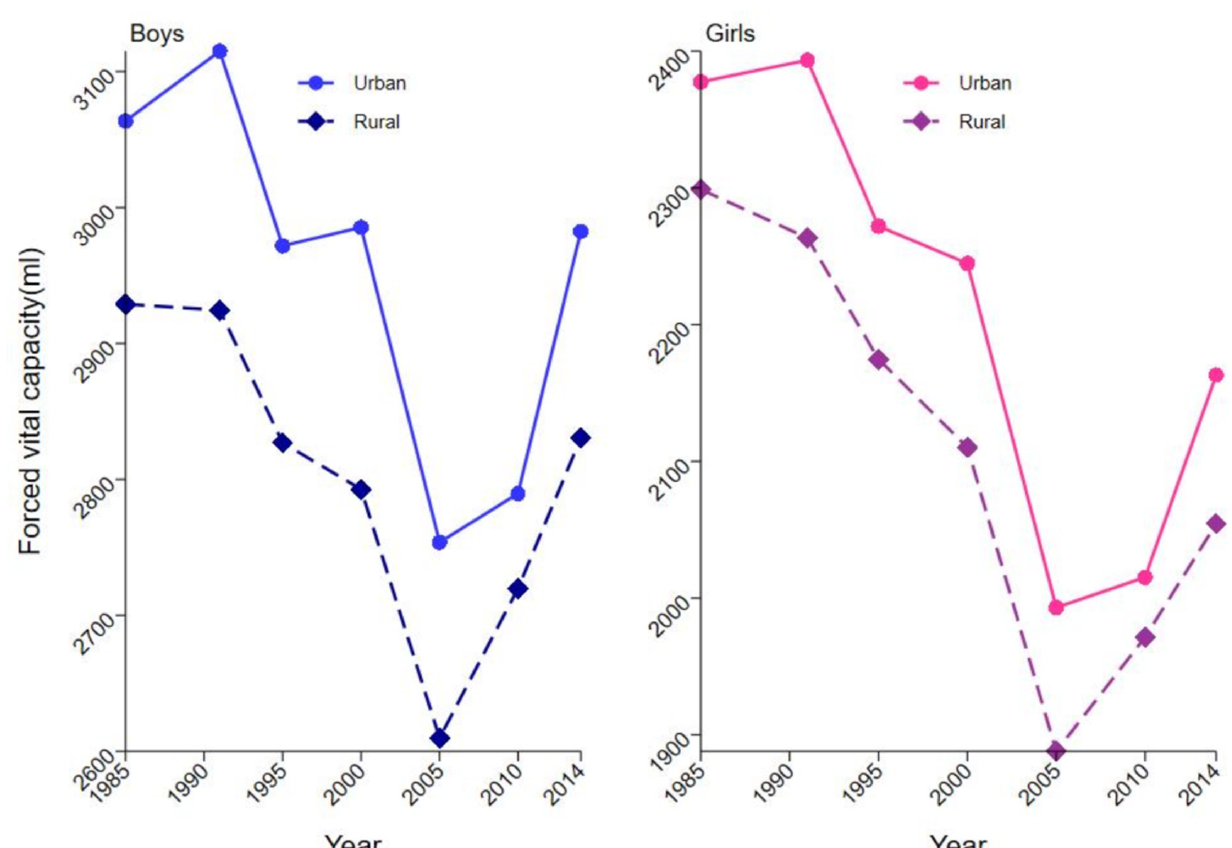
Figure 1. Trends in lung function indicators from 1985 to 2014.